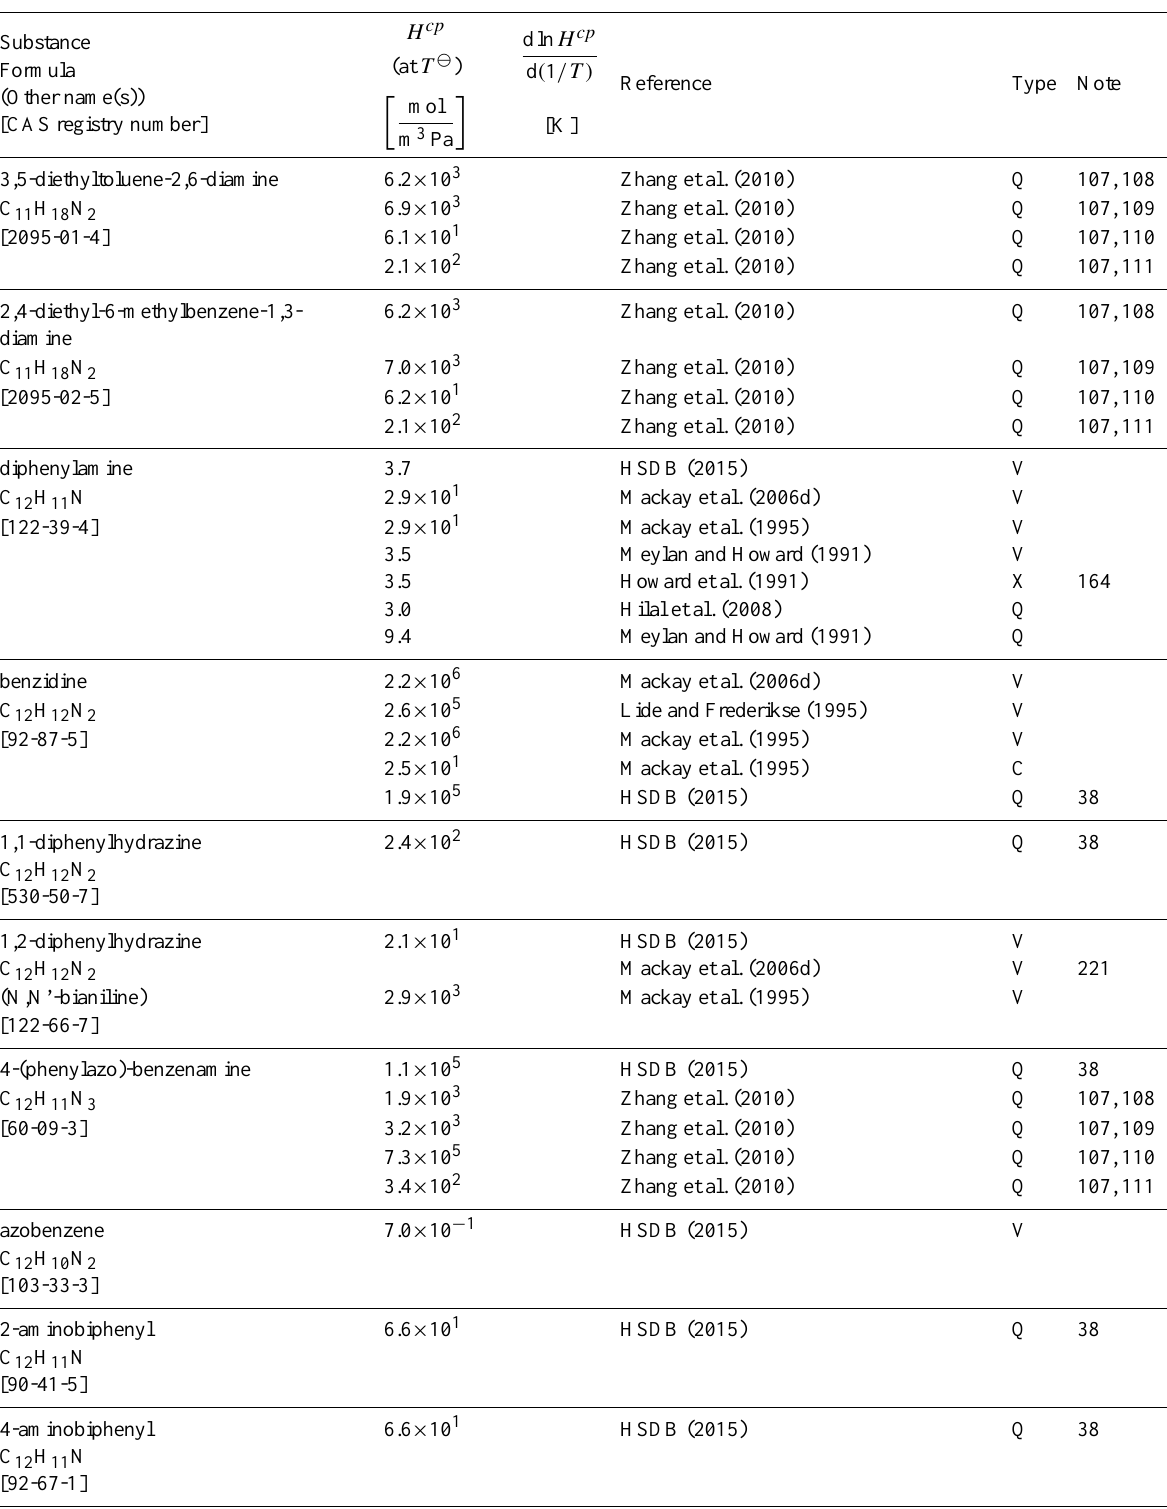
Table 6: Henry’s law constants for water as solvent